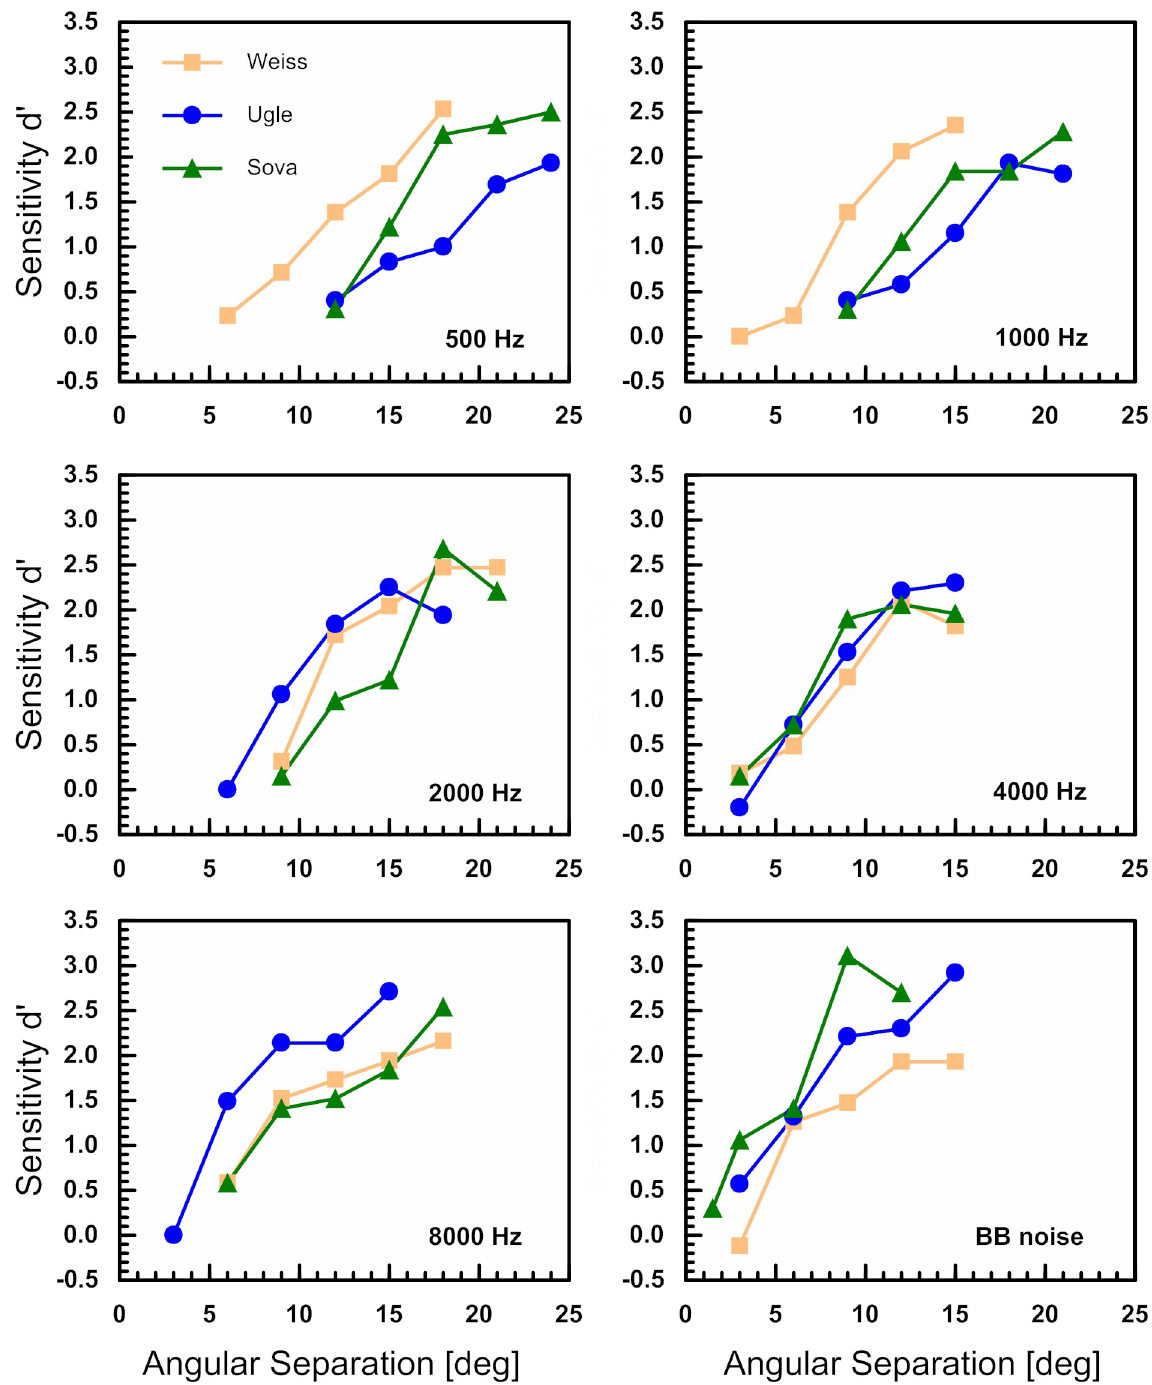
Fig 1. Psychometric functions for all six stimulus types and three owls obtained with a single reference position at 0˚ in azimuth. The barn owls sensitivity (d’) is plotted as a function of angular separation between reference and test stimuli. The different colours represent the different